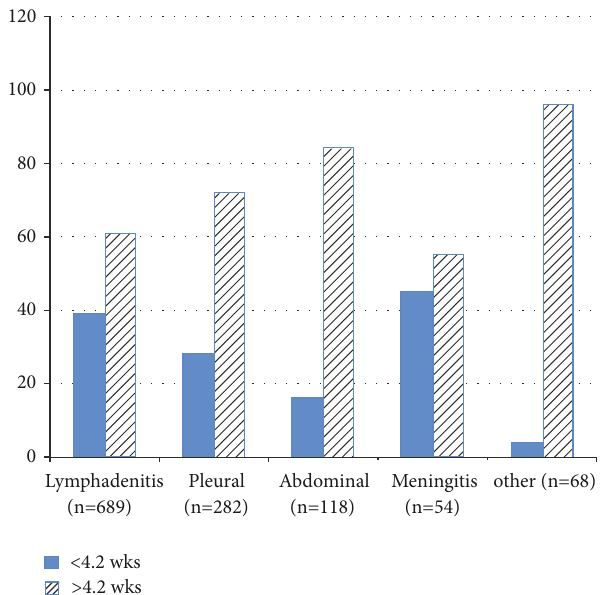
Figure 3: Proportion of patients with < 4.2 or > 4.2 weeks of total diagnostic delay in various forms of EPTB. More than 80% of patients with abdominal and other forms of EPTB had a prolonged diagnostic